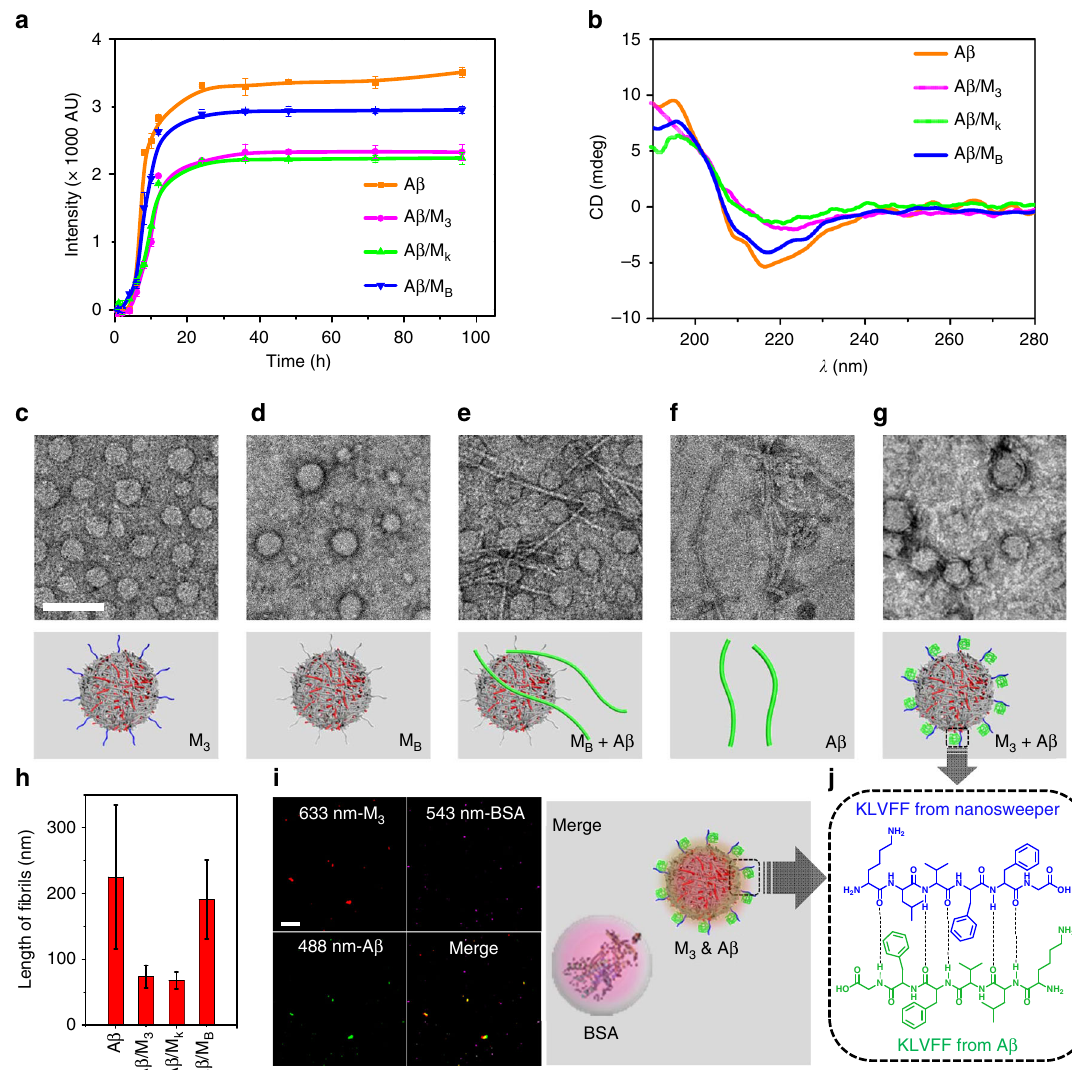
Fig. 3 The capture of A β by M 3 through co-assembly. a ThT fl uorescence assay of A β and A β /M 3 in 96 h, with A β /M K and A β /M B as controls. Data are presented as mean ± s.d. ( n = 3). b The CD spectra of A β and A β /M 3 at 24 h, with A β /M K and A β /M B as controls. c – g TEM images of M 3 , M B , A β /M B , A β and A β /M 3 at 24 h. h The statistical length of A β fi bers was averaged from 5 individual fi bers per group. Data are presented as mean ± s.d. ( n = 5). i CLSM images and schematic illustration of the mixture of Cy5-labeled M 3 , FITC-labeled A β and Cy3.5-labeled BSA. j The schematic illustration of the driving force for the capture of A β by hydrogen bonds. Scale bar: white bar in ( c ) is 100 nm, and ( i ) is 20 µ